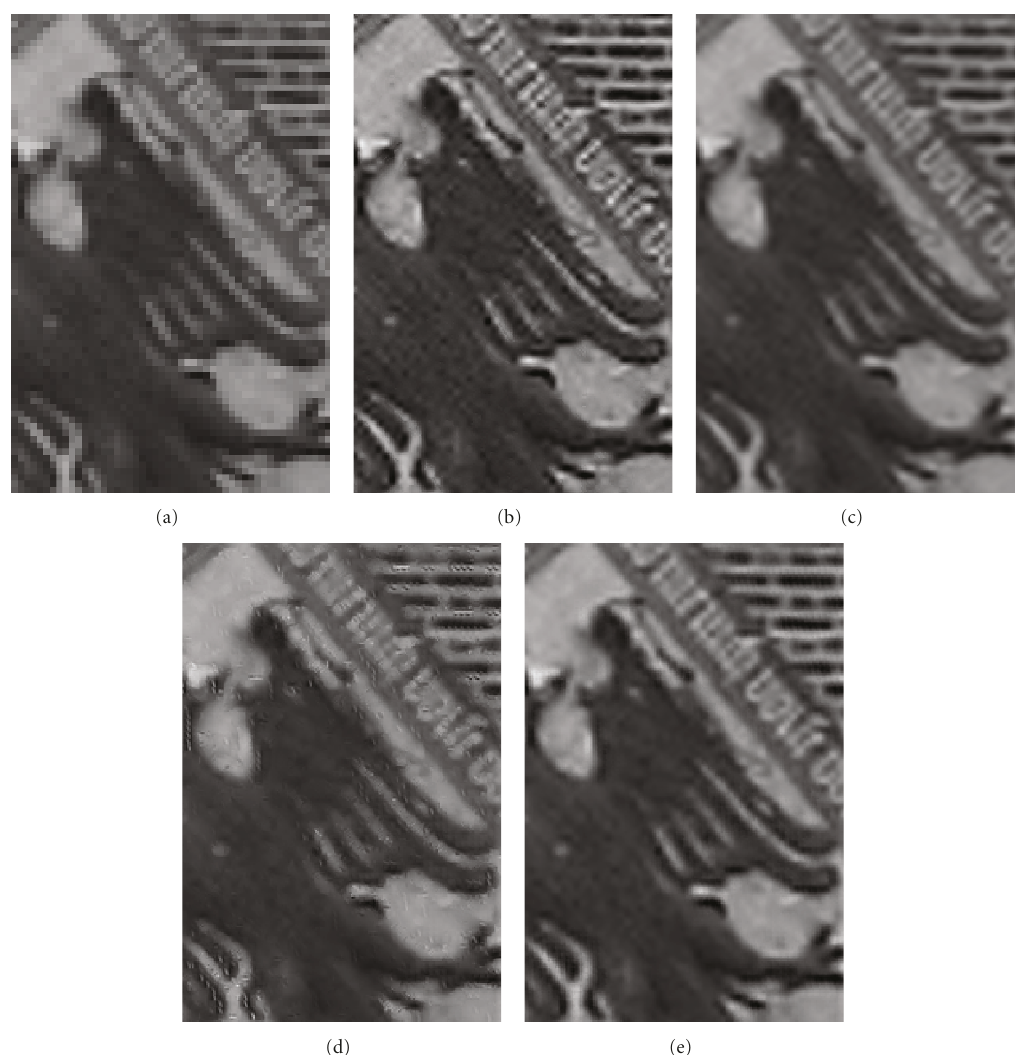
Figure 8: Zoomed portions of the results in Figure 7: (a) zoomed portion of Figure 7(b), (b) zoomed portion of Figure 7(c), (c) zoomed portion of Figure 7(d), (d) zoomed portion of Figure 7(e), and (e) zoomed portion of Figure